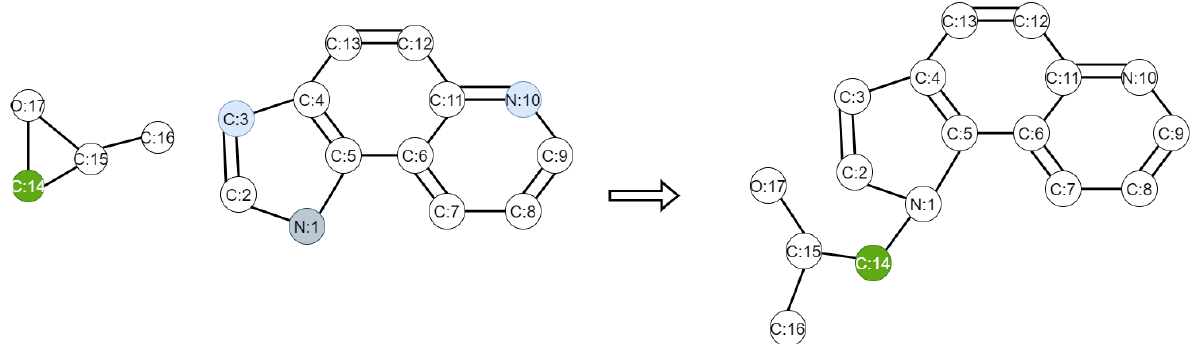
Figure 2. The top-1, top-2, top-3, and top-5 accuracies with labeled data size from 20% to 100%.